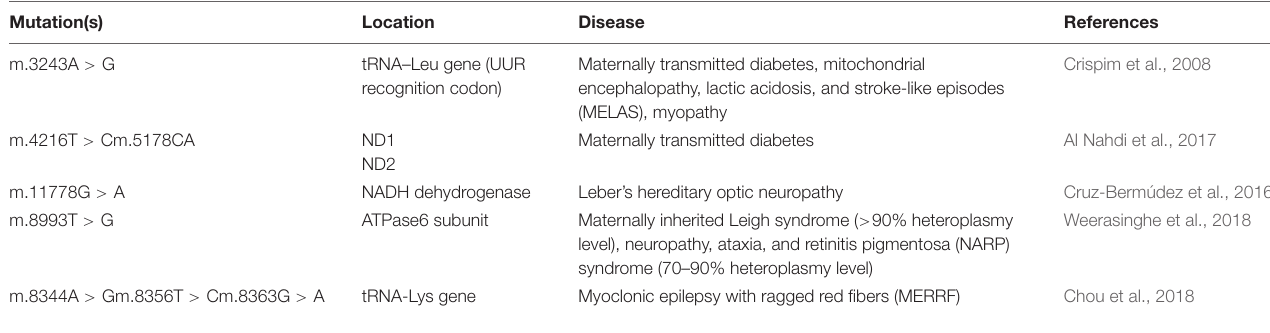
TABLE 1 | Some common mtDNA mutations associated with hereditary mitochondrial